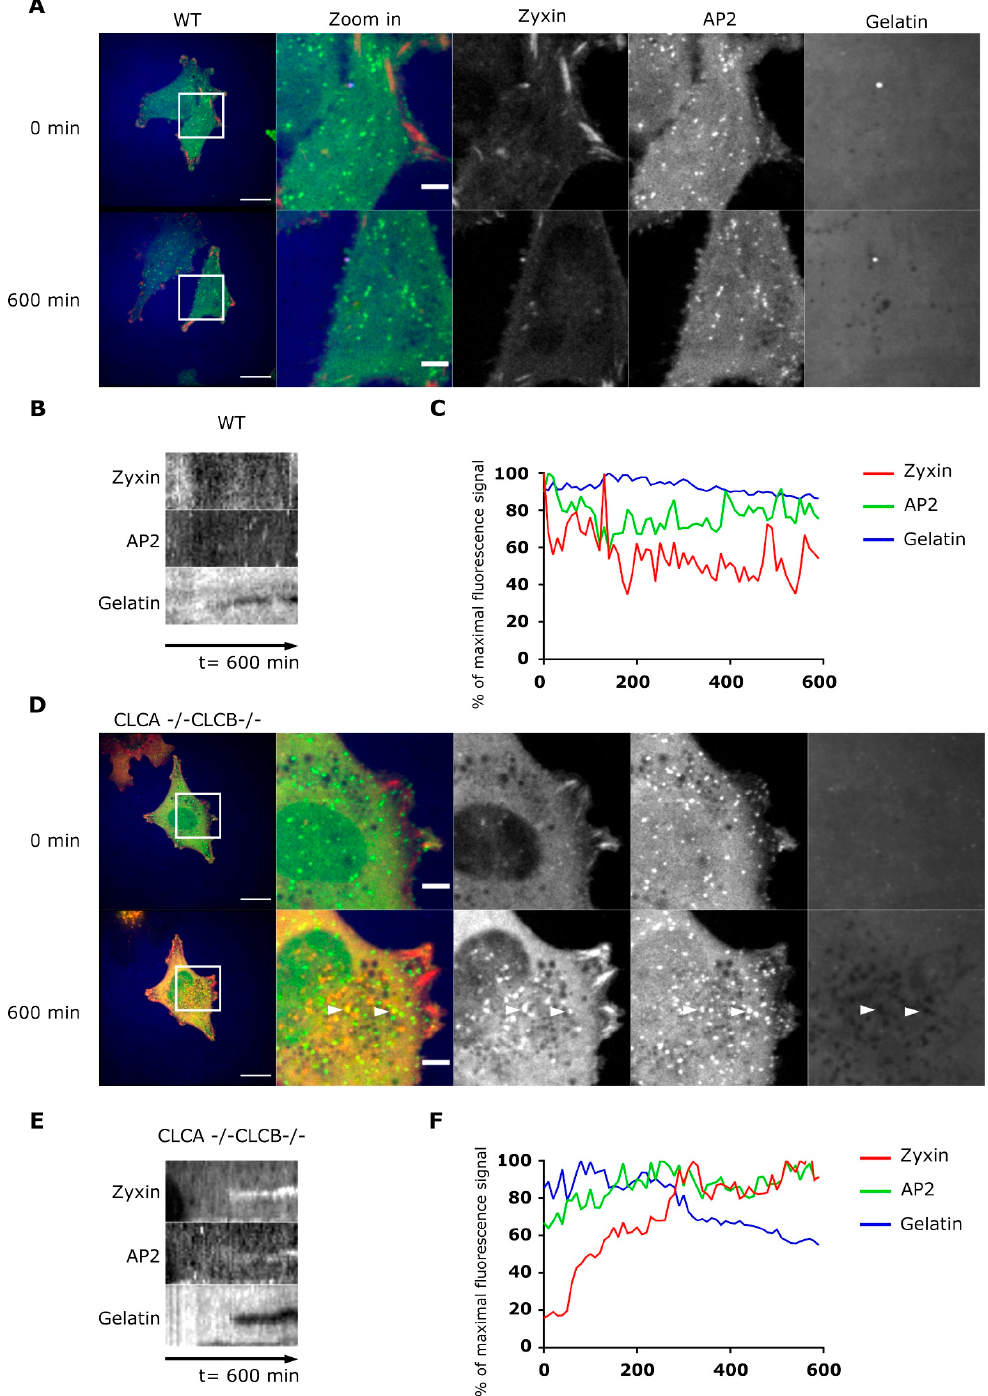
Figure 4. Actin patches in CLCA − / − CLCB − / − cells display proteolytic activities. ( A ) Representative live-cell confocal spinning disc microscopy of U373 WT cells stably expressing AP2-GFP (green) and transiently expressing mCherry-zyxin (red) seeded onto Alexa Fluor 647-labelled gelatin (blue) coated coverslips. Live-cell confocal imaging was performed for 600 min. Here, representative pictures at the beginning and at the end of imaging are displayed. The scale bar equals 20 µ m and 5 µ m for the “full cell” view and zoom in region, respectively. ( B ) Kymograph of WT U373 cells expressing AP2-GFP and mCherry-zyxin seeded on fluorescent gelatin (600 min). ( C ) Representative fluorescence intensity profiles overtime of WT U373 cells expressing AP2-GFP (green), mCherry-zyxin (red) seeded on Alexa Fluor 647-labelled gelatin (blue). ( D – F ) same as ( A – C ) except for CLCA − / − CLCB − / − U373